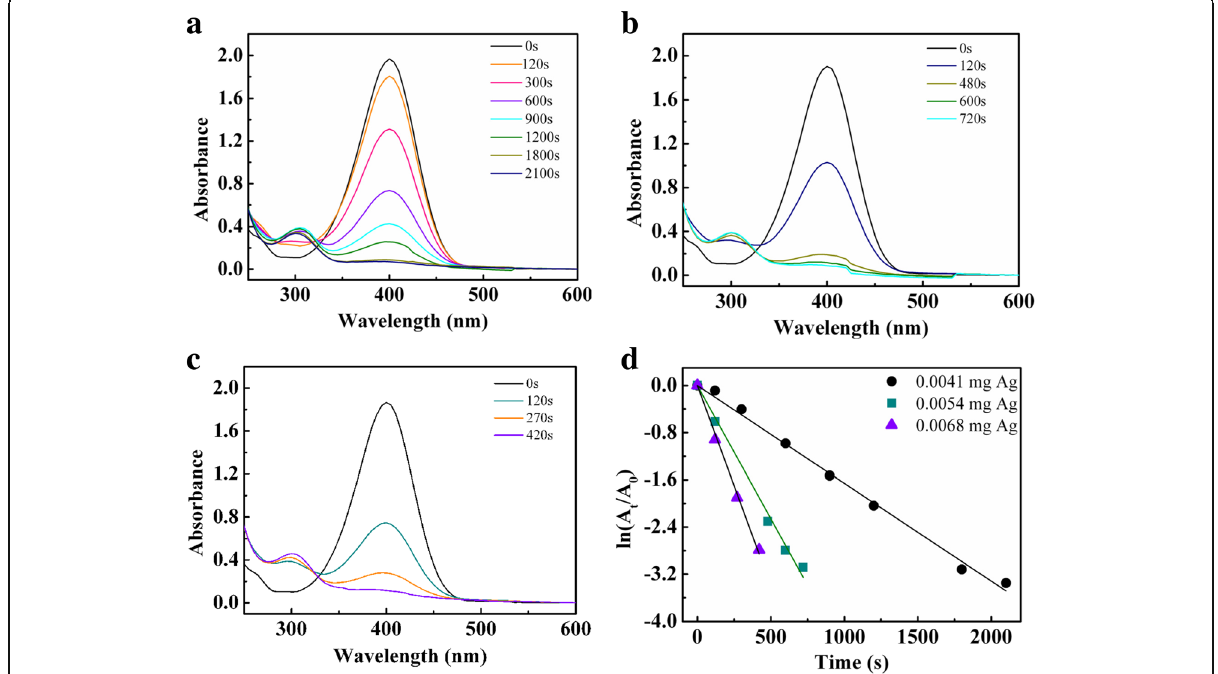
Fig. 9 a UV-vis spectra of 0.12 mM 4-NP with 36 mM NaBH 4 in the presence of nAg@PSA4 nanocomposites (containing 0.0041 mg Ag). b UV-vis spectra of 0.12 mM 4-NP with 36 mM NaBH 4 in the presence of nAg@PSA4 nanocomposites (containing 0.0054 mg Ag). c UV-vis spectra of 0.12 mM 4-NP with 36 mM NaBH 4 in the presence of nAg@PSA4 nanocomposites (containing 0.0068 mg Ag). d The plot of ln(A t /A 0 ) against the reaction time in the presence of nAg@PSA4 as a